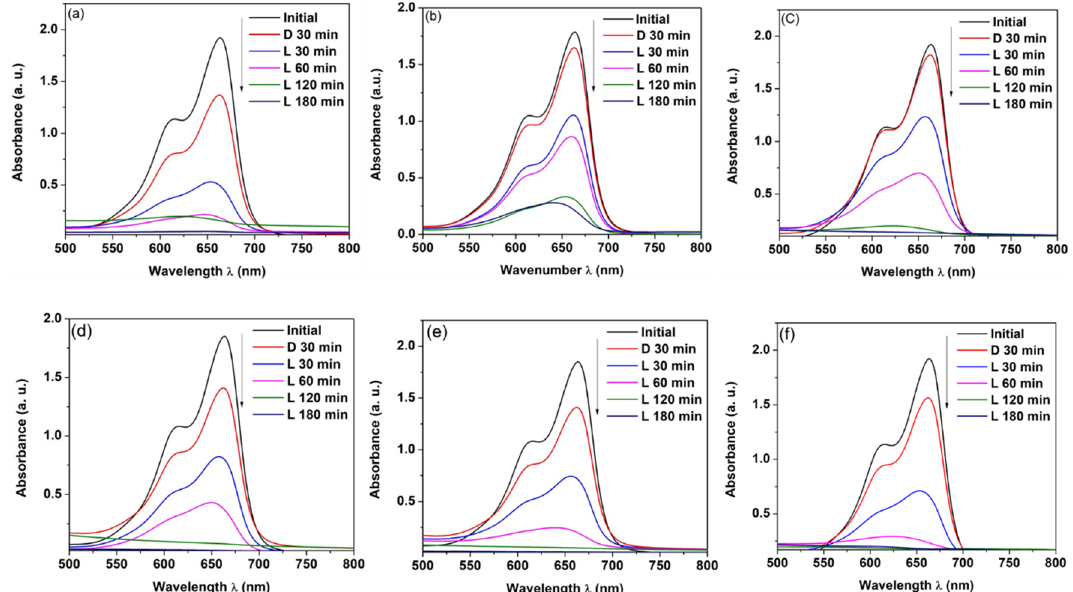
Figure 6. Absorbance vs. wavelength graph for degradation of methylene blue by using pristine ( a ) TiO 2 (ST-0), ( b ) SnS 2 (ST-100) and SnS 2 /TiO 2 nanocomposites (( c ) ST-5, ( d ) ST-10, ( e ) ST-15 and ( f ) ST-20) as photocatalysts at different time intervals under direct sunlight. Table 2. Comparison of the amount of hydrogen evolved and rate constant of the degradation re- action of MB by using pure SnS 2 , TiO 2 , and SnS 2 -embedded TiO 2 nanocomposite over simulated irradiation with the bandgap of these materials.